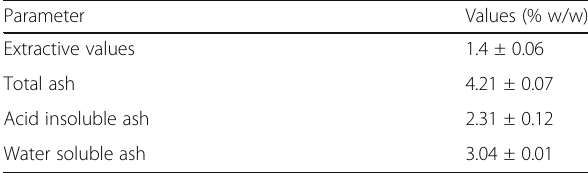
Table 1 Physicochemical analysis of H.clathratus Parameter